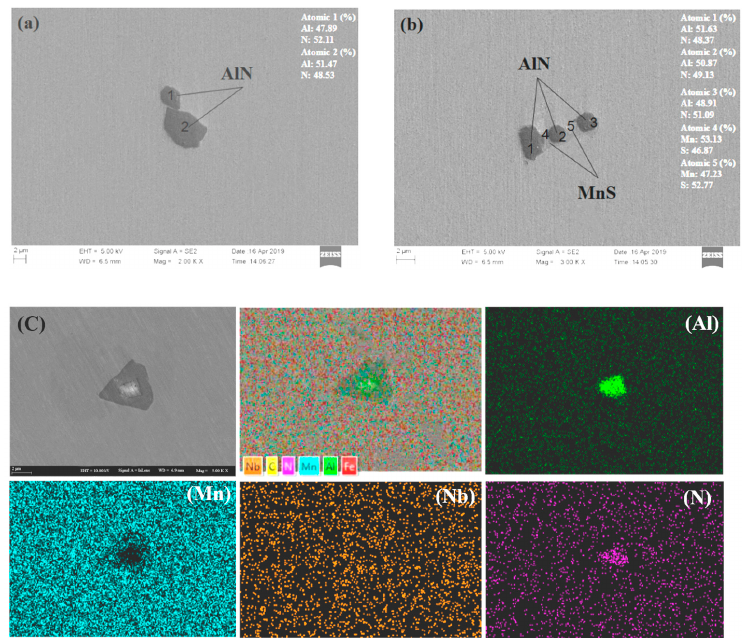
Figure 3. Morphology of typical inclusions in TWIP steel (steel B) (the mass fraction of Al is 1.49%). ( a ) AlN inclusion; ( b ) AlN-MnS complex inclusion; ( c ) The surface scan of AlN-MnS complex inclusion. Metals 2021 , 11 , x FOR PEER REVIEW 3.1.3. TWIP Steel Containing 1.5% Al and 0.04% Nb